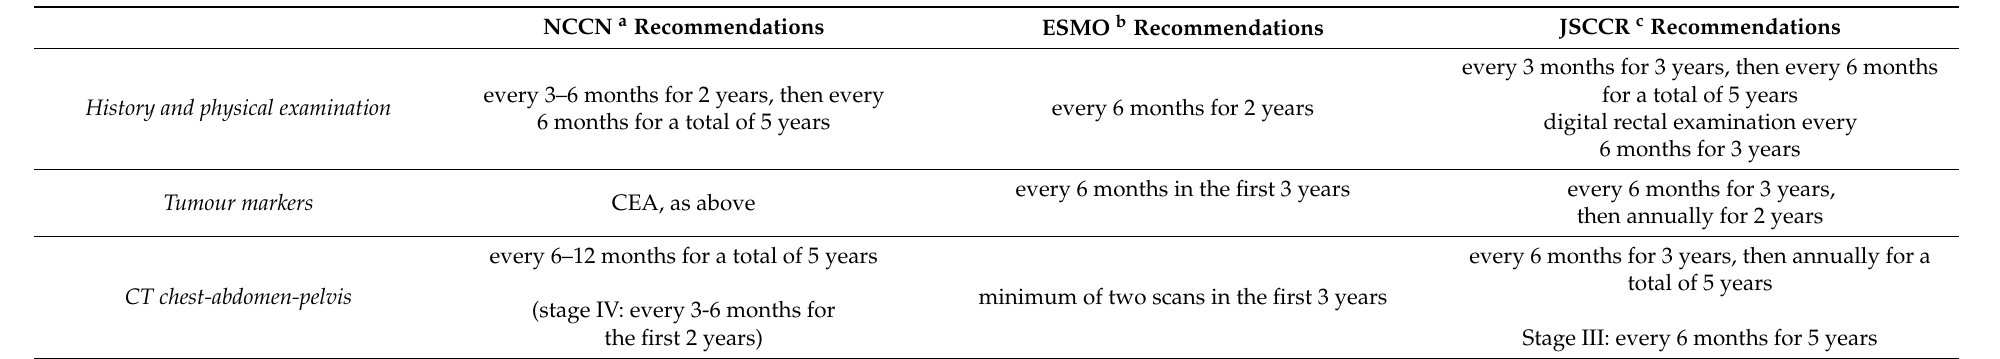
Table 6. Rectal cancer: Postoperative